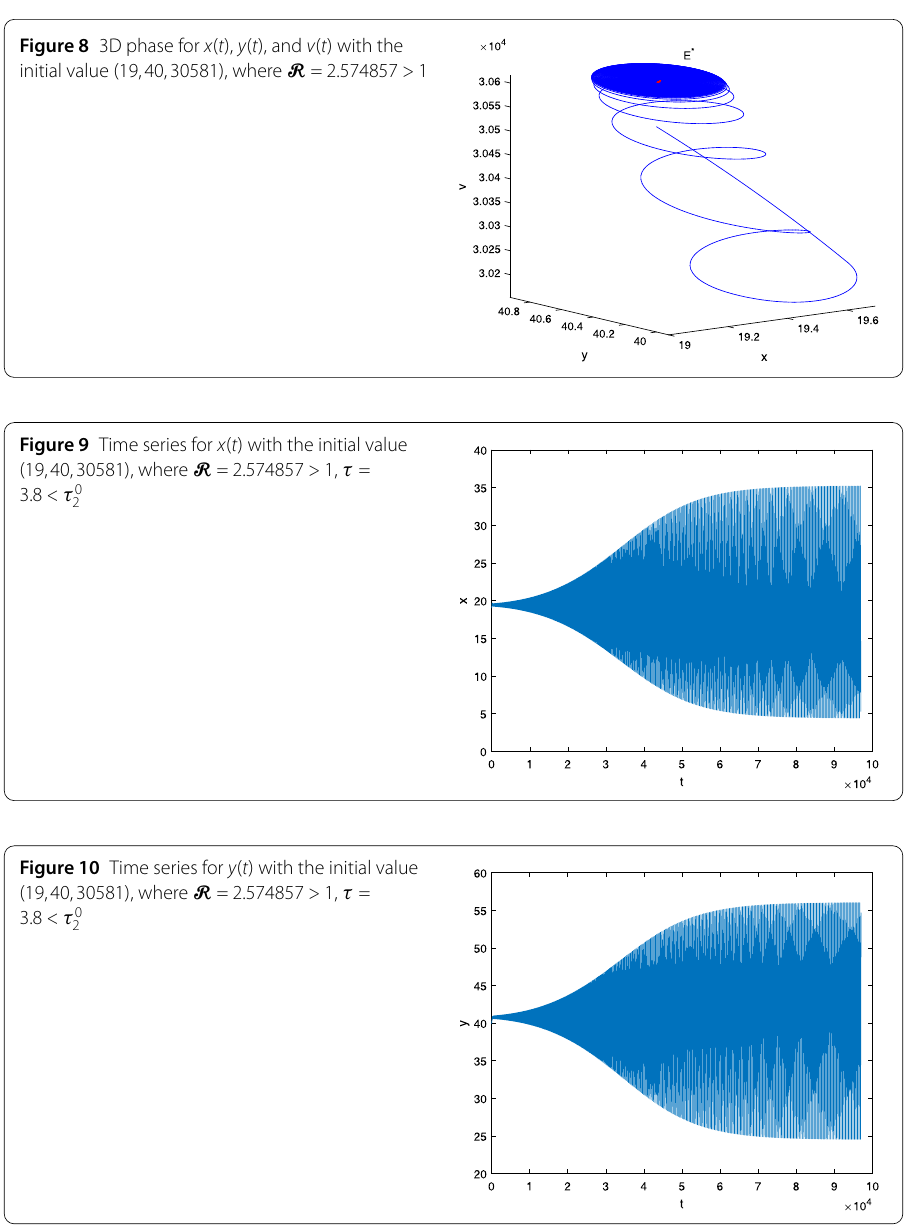
Figure 9 Time series for x ( t ) with the initial value (19,40,30581), where R = 2.574857 > 1, τ =